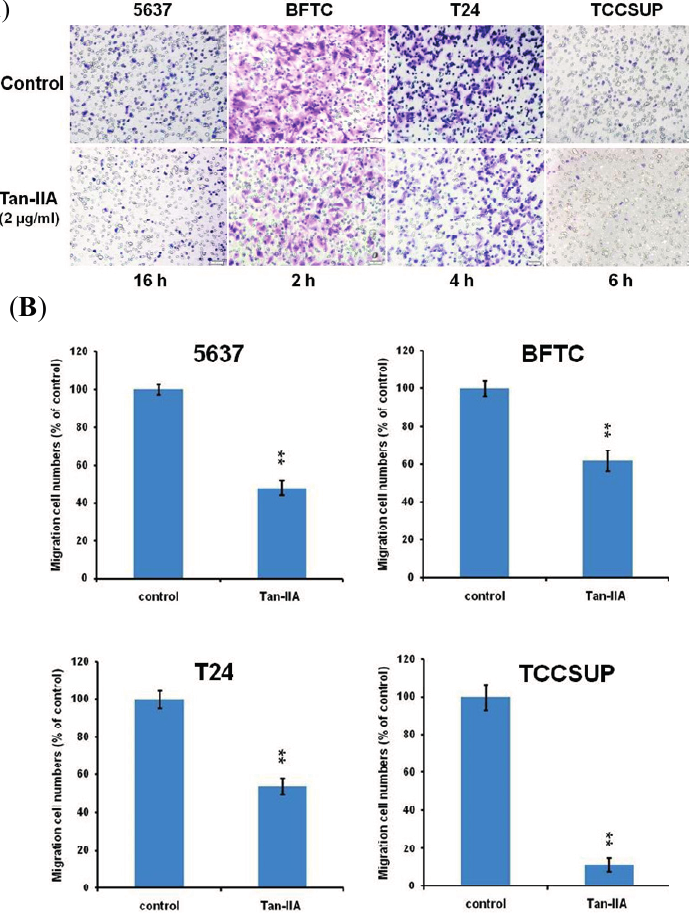
Figure 5. Effect of Tan-IIA on the migration of human bladder cancer cells-transwell test. ( A ) human bladder cancer cells were pretreated with 0.2% DMSO as control or 2 μ g/mL Tan-IIA for 24 h and then seeded onto the transwell hanging insert for different time points (5637: 16 h, BFTC: 2 h, T24: 4 h and TCCSUP: 6 h). Images were captured using an inverted microscope with 200× magnification; Scale bar: 50 μ m; ( B ) The migration of human bladder cancer cells was quantified by enumerating the stained cells that migrated into the underside of the hanging insert membrane. Data are presented as means ± S.D. from three different experiments. ** p < 0.01 versus vehicle.